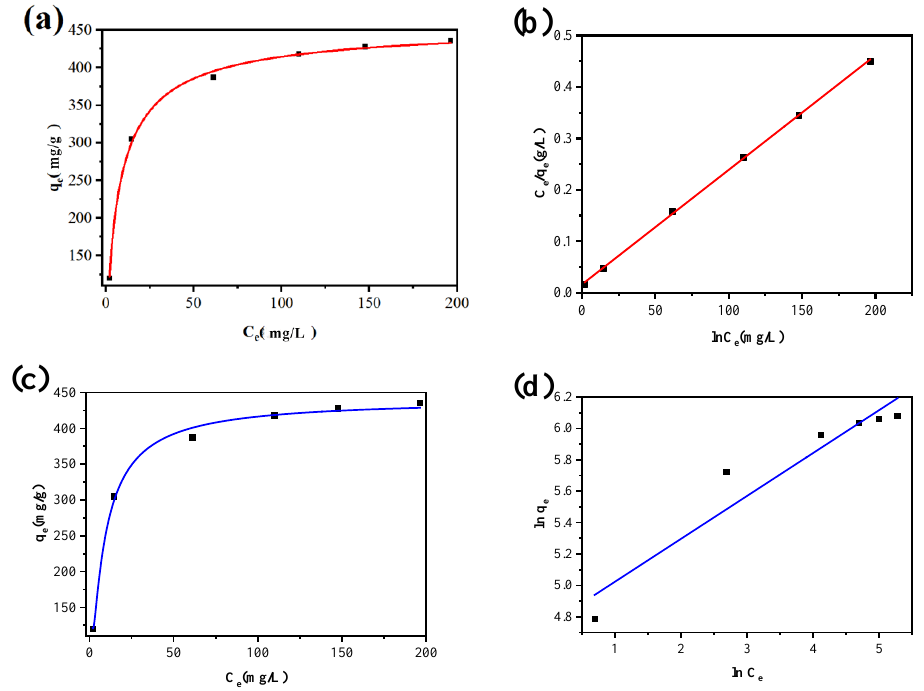
Figure 14. ( a ) Langmuir nonlinear fitting; ( b ) linear fitting for MGO@ZIF-8 adsorption of copper ions; ( c ) Freundlich nonlinear fitting; and ( d ) linear fitting for copper ion adsorption. Table 5. Adsorption isothermal model parameters of MGO@ZIF-8 for Cu 2+. —— Langmuir Freundlich